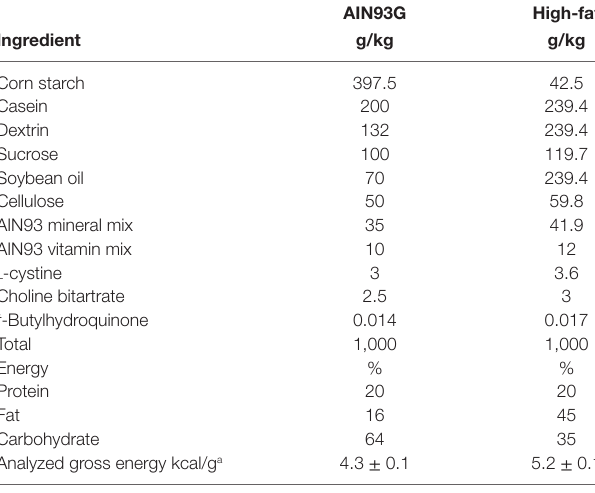
Table 1 | Composition of experimental